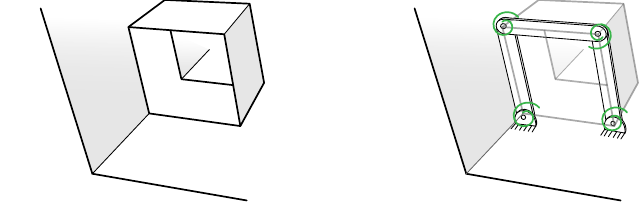
Figure 4. A rigid-foldable version of the square twist origami con- structed from polypropylene sheet and paper. The polypropylene shows that it behaves rigidly, where bending is only allowed at the Fig. 4. A common double slit kirigami modeled and its correspond- ing PRBM. Table 1. Origami Applications by LEM Technology Category